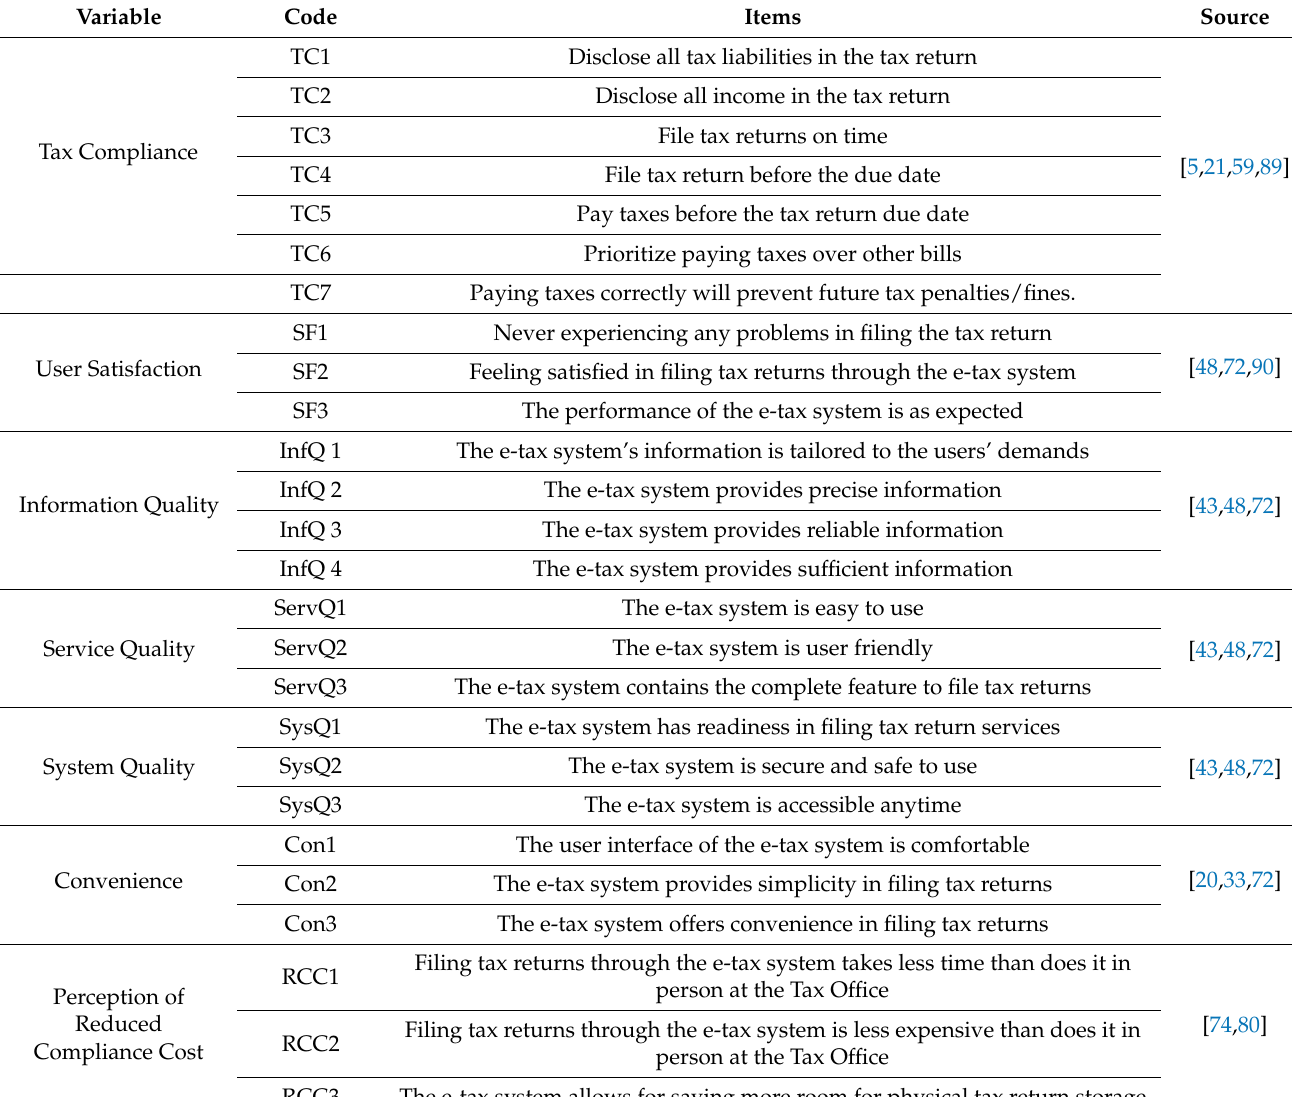
Table 2. Measurement of the